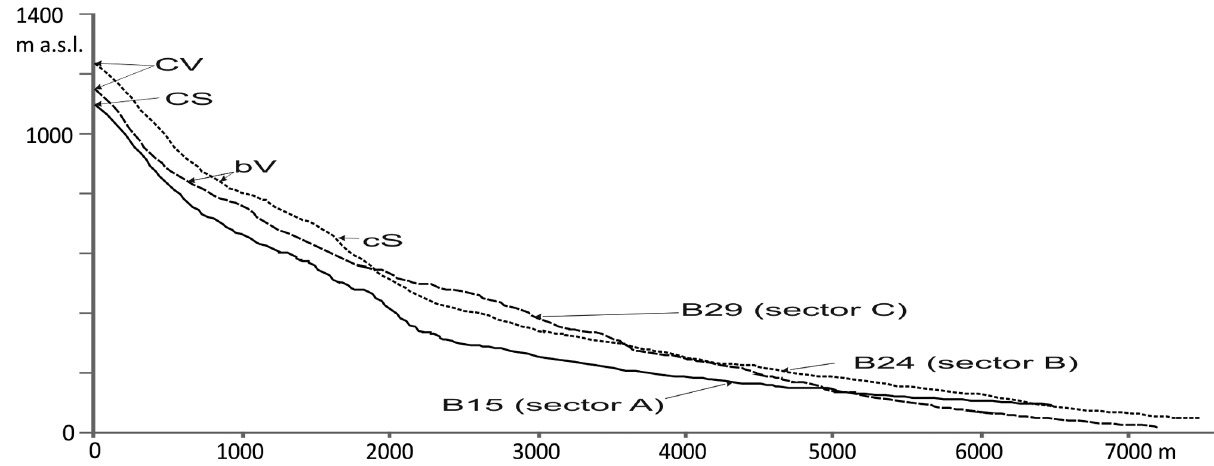
Figure 7. Topographical profiles of the nos. 15, 24 and 29 basins respectively located in the A, B and C sectors of the Somma-Vesuvius vol- canic complex CV: active crater of the Vesuvius; CS: rim of the Mt. Somma caldera; cS: buried morphologic rim of Mt. Somma; bV: base level of the Vesuvius